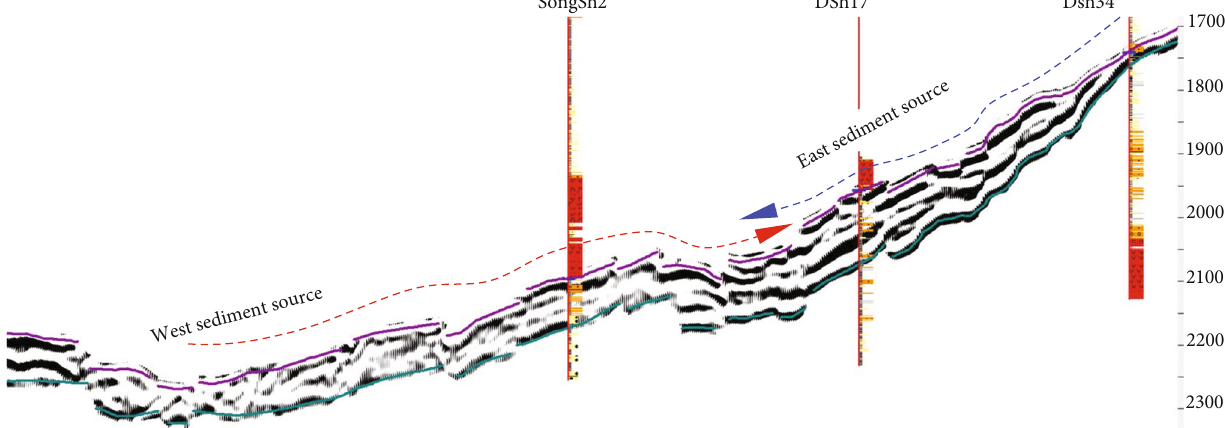
Figure 6: Di ff erences of seismic re fl ection characteristics caused by east and west directional deposition.